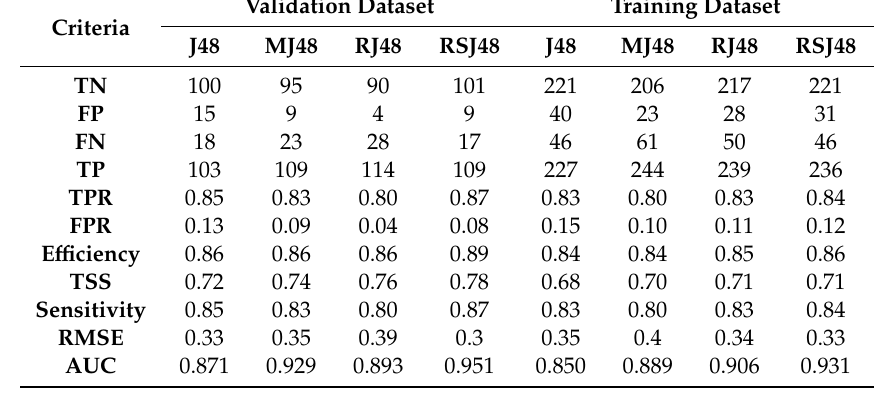
Table 4. Values of e ffi ciency (E), true skill statistic (TSS), sensitivity, and root mean square error (RMSE).